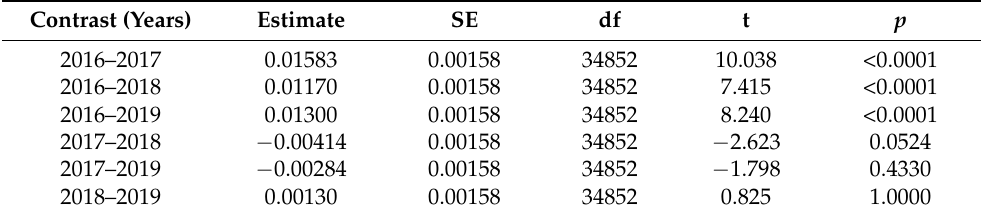
Table 1. Pairwise comparison of linear regression slope coefficients (in Figure 2b). p -values adjusted using Bonferroni correction. Significance level set at